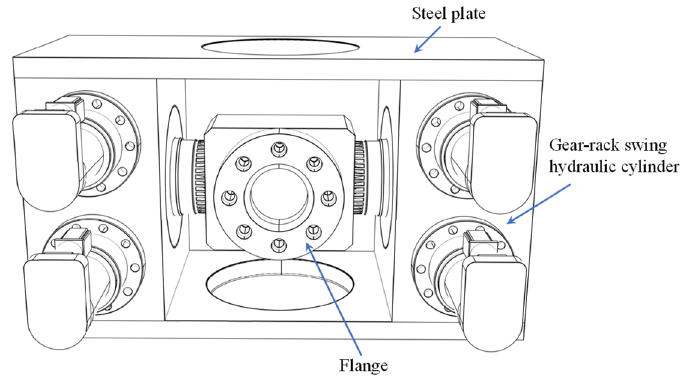
Figure 8. Schematic of the bending moment loading system.